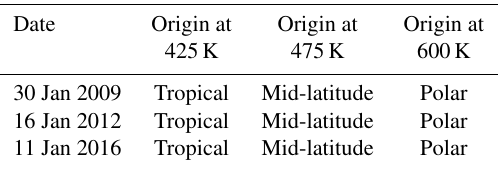
Table 3. Origin of ozone-poor air at isentropic levels for low-ozone events in January. Origin at Origin